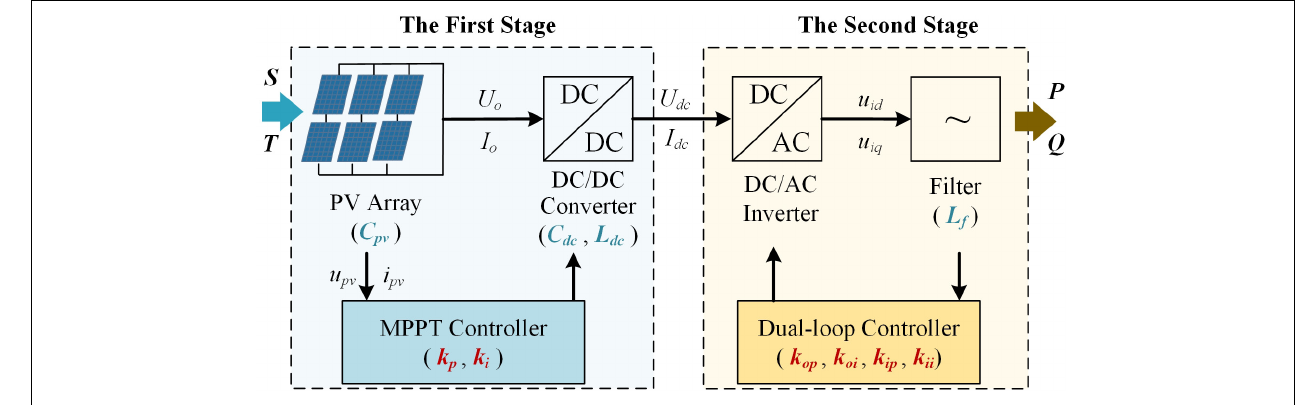
FIGURE 1 | The structure of the two-stage PV